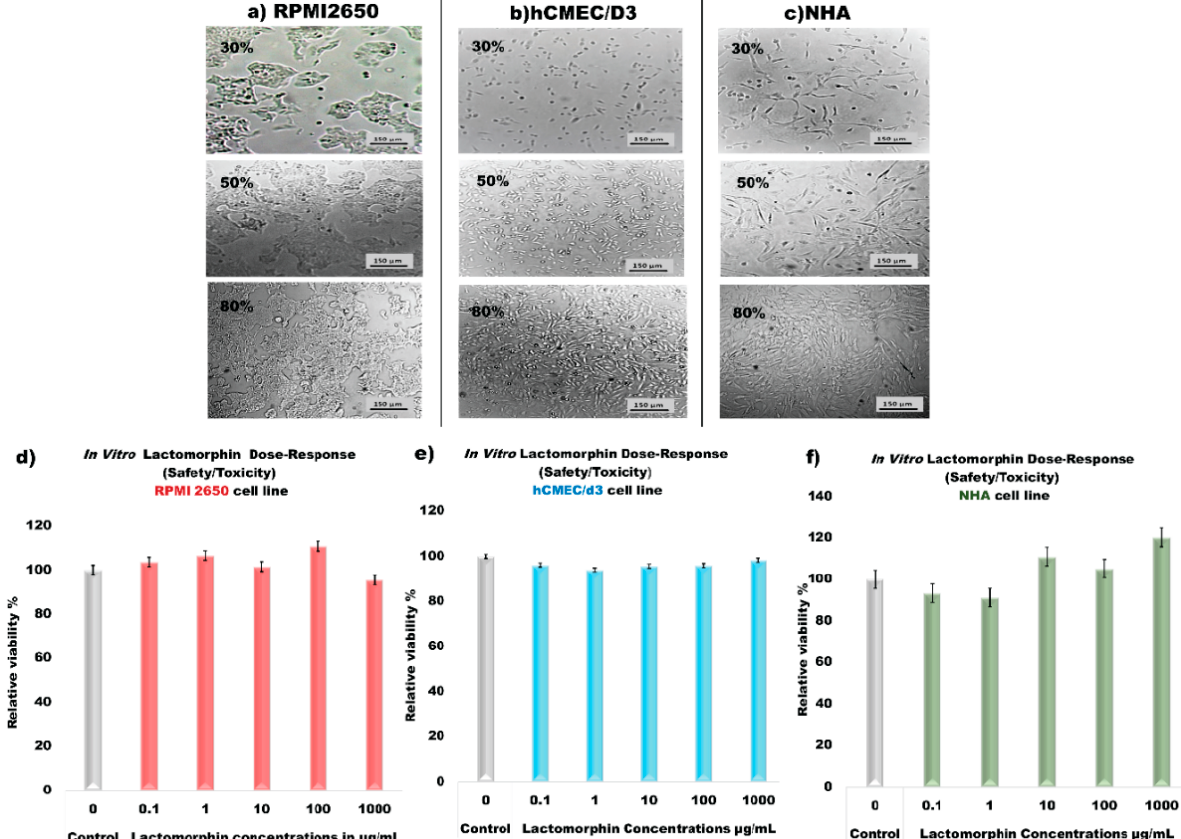
Figure 12. Cells morphology and at 30%, 50%, and 80% confluency during the sub-culturing as imaged with a phase-contrast microscope. Scale bar: 150 µ m of ( a ). RPMI2650 cell line; ( b ). hCMEC/d3 cell line; ( c ). NHA cell line; Resazurin assay results of the cell viability experiment after the exposure to different concentrations of Lactomorphin for ( d ). RPMI2650 cell line; ( e ). hCMEC/d3 cell line; ( f ). NHA.